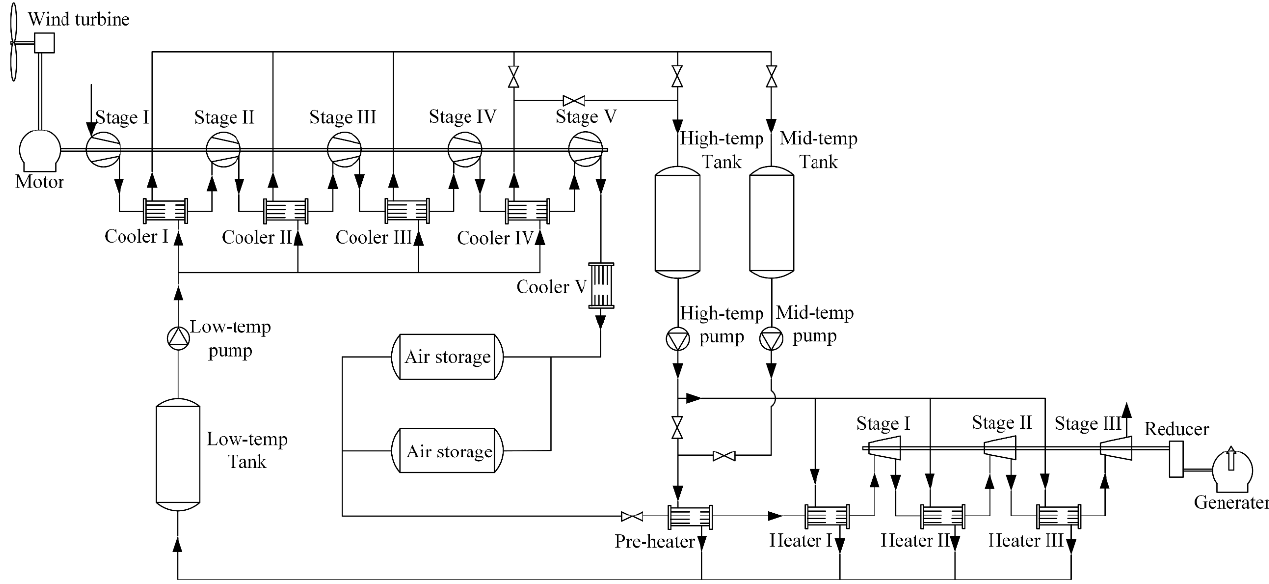
Figure 3. Model of TICC-500.